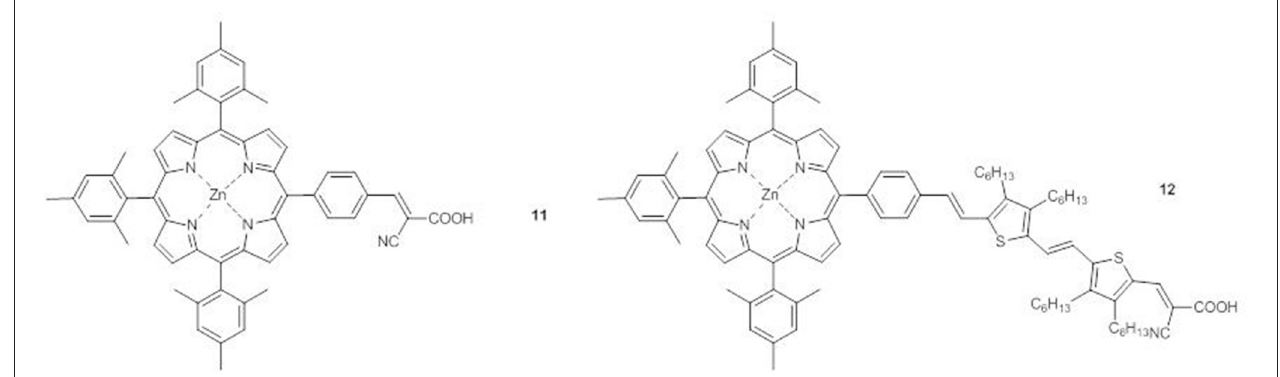
FIGURE 6 | Zn II porphyrins 11 and 12